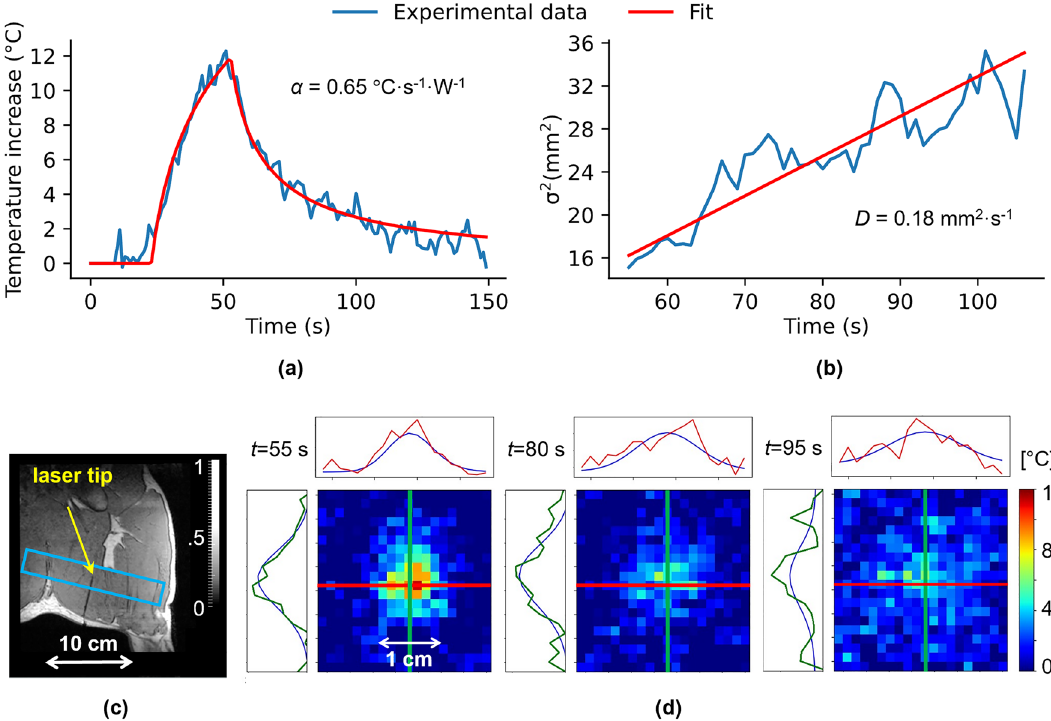
Figure 4. Estimation of absorption α ( ◦ Cs − 1 W − 1 ) and diffusion D ( mm 2 s − 1 ) coefficients from the test shot in pig muscle. ( c ) Laser tip placement visualization (left leg) on a 3D MPRAGE coronal view with thermometry EPI stack of slices used in blue. ( a ) The logarithmic fit of the focal light beam point temporal temperature profile to estimate α . ( b ) Temperature maps obtained at times t = [55, 80, 95] s and the resulting fit with a 2D Gaussian function (blue curves) compared to their spatial profile centered on the focal point (X direction in red, Y direction in green). ( d ) The fit of the spatial heat Gaussian width temporal evolution to estimate D regulation algorithm for both experiments (Table 1, bottom part). Red curves in both graphs show temperature evolution in a non-heated single voxel ( σ baseline , a = 0.47 °C, σ baseline , b = 0.69 °C). Images on Fig. 5 are tempera- ture maps obtained in the middle of each plateau ( t a = [300, 600, 1000] s and t b = 450 s). The difference between target and maximal temperature curves during the heating period are plotted on the right of Fig. 5, together with the mean (red lines) and RMSE values (black dot lines). Mean differences and RMSE (mean, RMSE) for the total heating duration of the experiment (a) are (−0.05 °C, 0.82 °C) and (0 °C, 0.66 °C), (−0.02 °C, 0.77 °C), and (0.01 °C, 1.02 °C), are values corresponding to each plateau. For experiment (b), values of mean difference and RMSE are (−0.1 °C, 1.4 °C) for the total heating duration and (0.05 °C, 1.32 °C) over the plateau of + 30 °C.